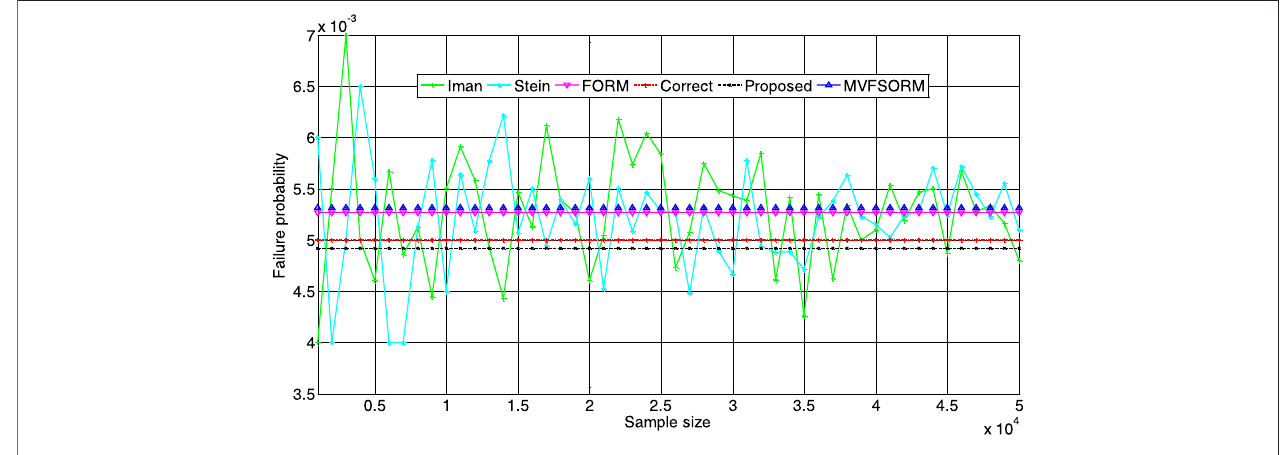
FIGURE 5 | Failure probability calculated with different algorithms.